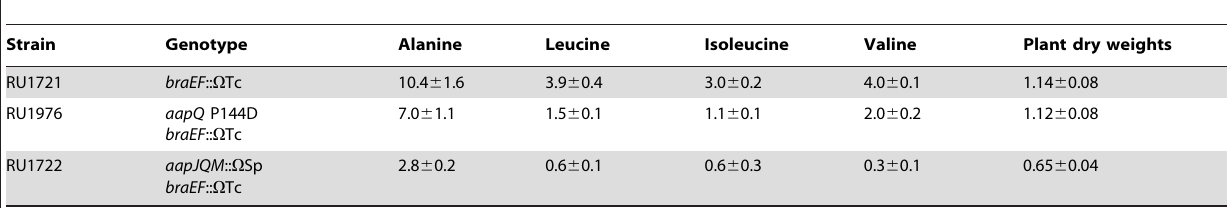
Table 2. Transport rates of branched-chain amino acids and plant dry weights by strains of R. leguminosarum bv. viciae.